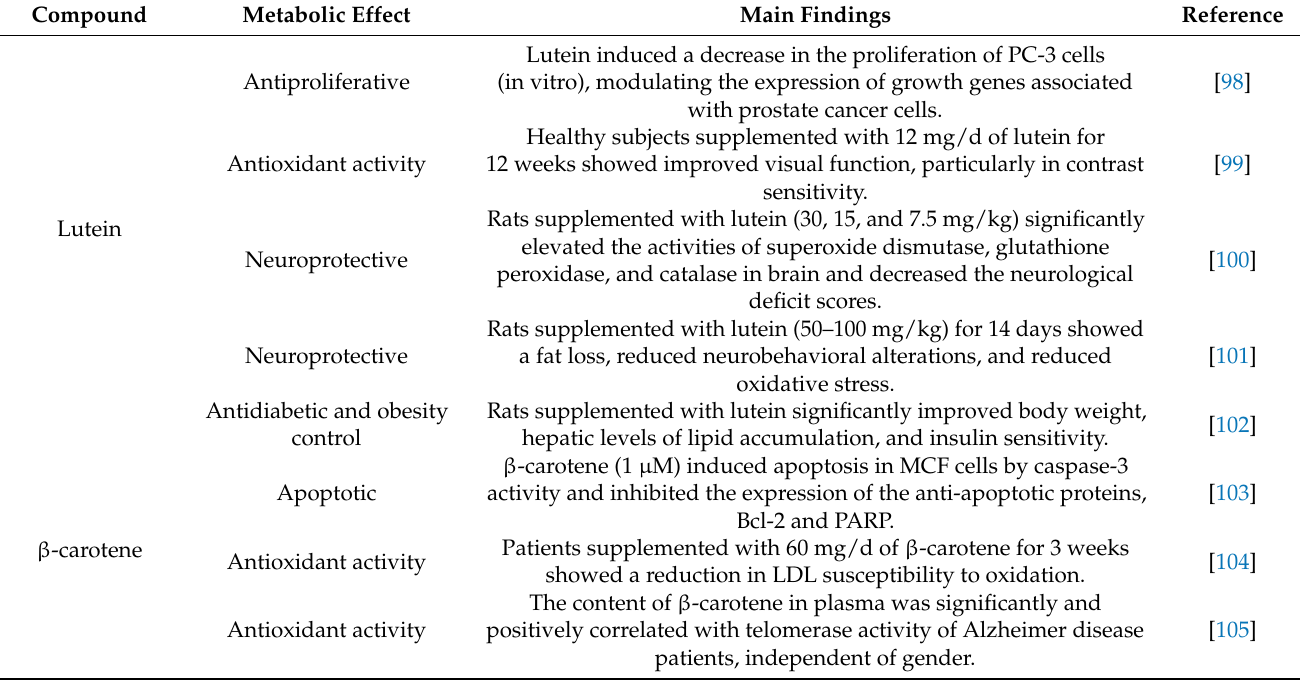
Table 4. Health benefits of carotenoids found in kale, determined through in vivo and in vitro studies.